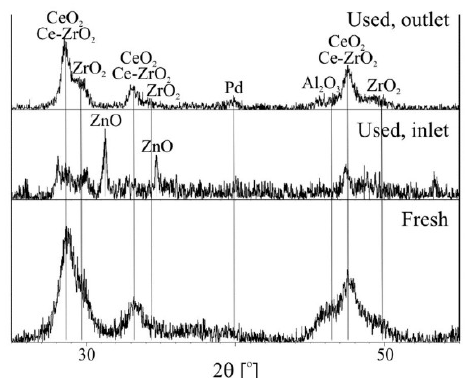
Figure 18. XRD patterns of the fresh and used natural gas catalysts.